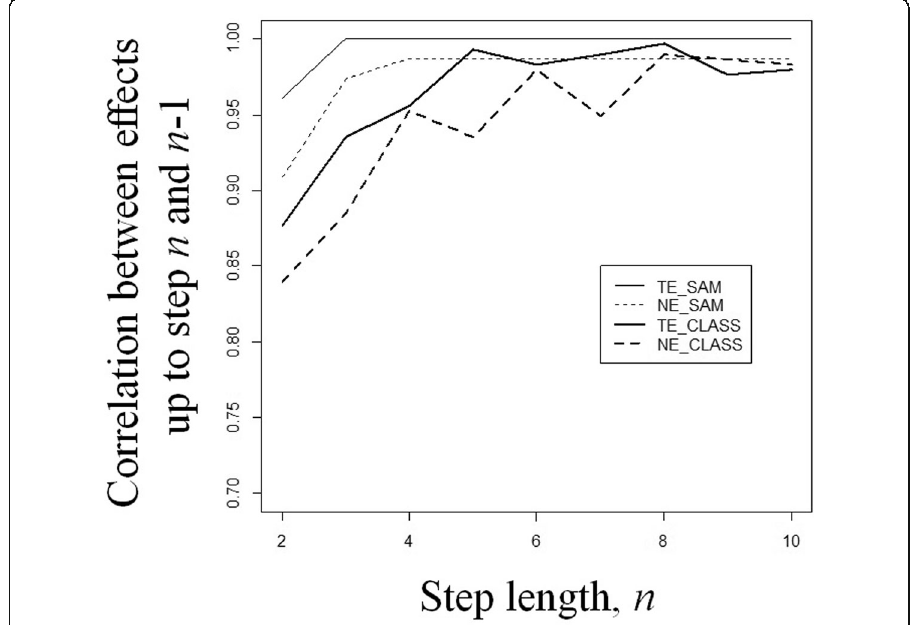
Fig. 10 Correlation between effects up to step n and n -1 for various n from one to ten. Thin solid line (TE_SAM) and thin dotted line (NE_SAM) respectively represent the results from total effect and net effect calculated on Sampson ’ s monk social network. Thick solid line (TE_CLASS) and thick dotted line (NE_CLASS) respectively represent the results from total effect and net effect calculated on the classroom social network shown in Fig.